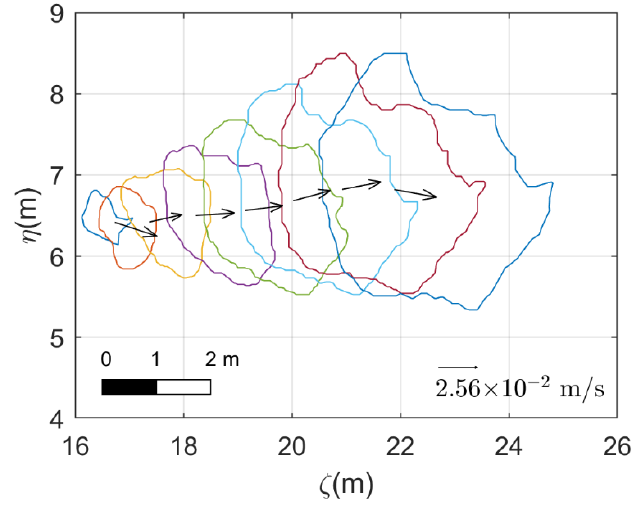
Figure 5. Selected dye contours for velocity field computation, and the computed velocities for each contour. The length scale and the velocity scale are shown in the lower part of the figure.